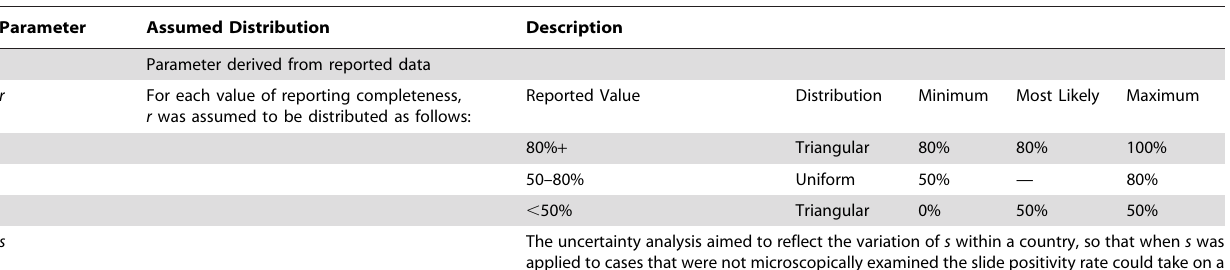
Table 1. Distributions assumed for parameters used in method